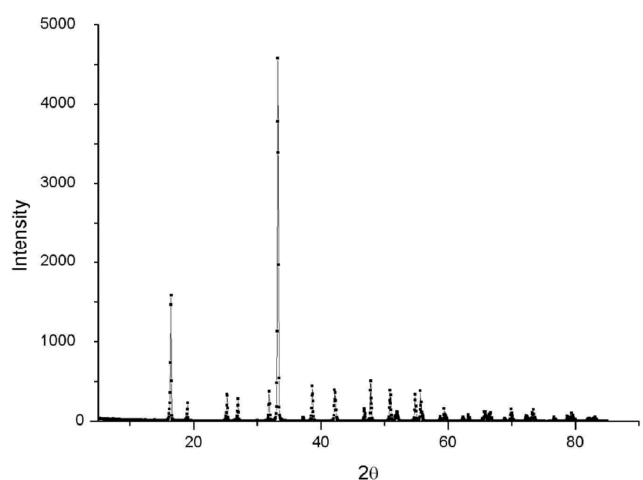
Figure 4. X-ray powder diffraction for as-grown Nd:YAB crystal. Table 1. Lattice parameters of YAl 3 (BO 3 ) 4 .